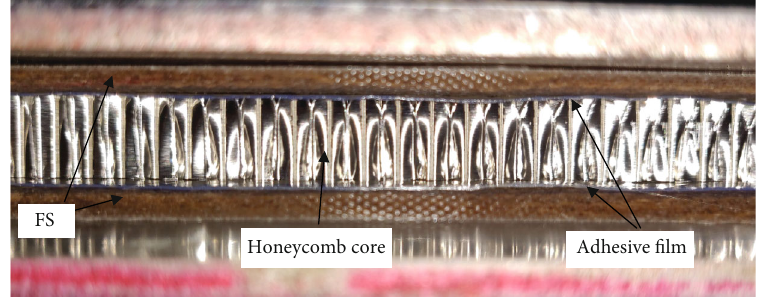
Figure 3: Curing of the composite sandwich structure.